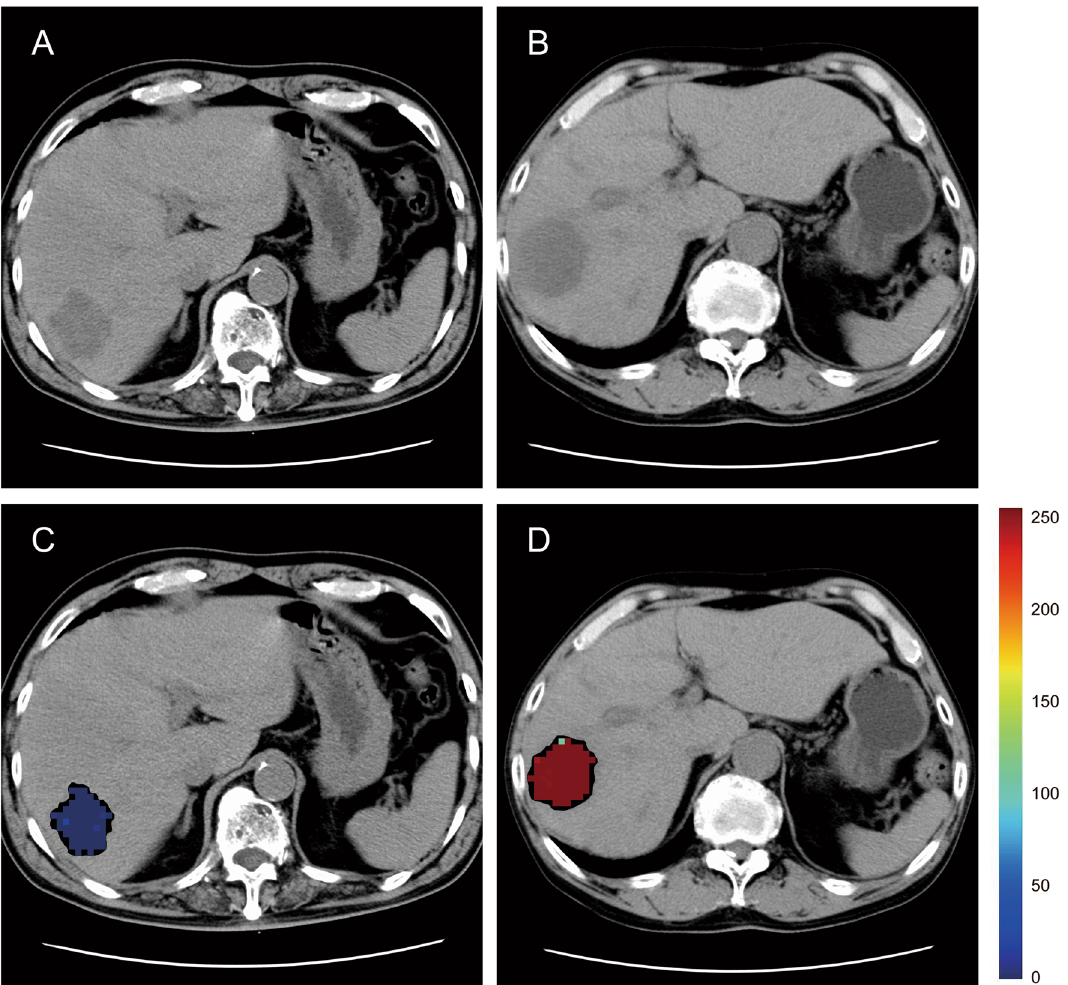
Figure 3. A heatmap of iCCA on a preoperative plain CT using our prediction model. The color bar illustrates the degree of probability the model paid to it. Red areas represent a high risk of early recurrence; blue areas represent a low risk of early recurrence. ( A ) original image of a non-early recurrence case; ( B ) original image of an early recurrence case; ( C ) heatmap of a non-early recurrence case; ( D ) heatmap of an early recurrence